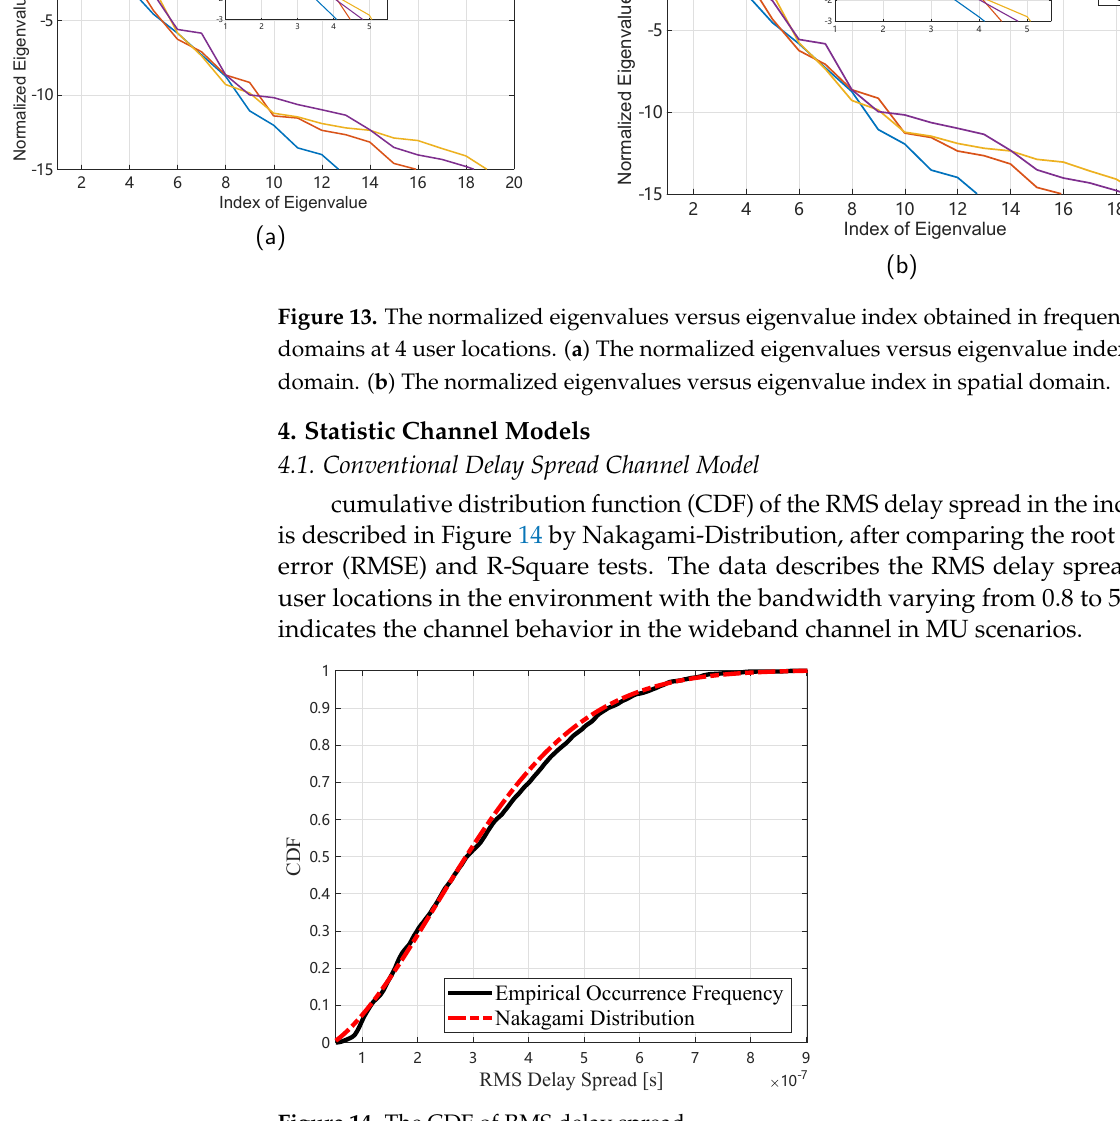
Figure 14. The CDF of RMS delay